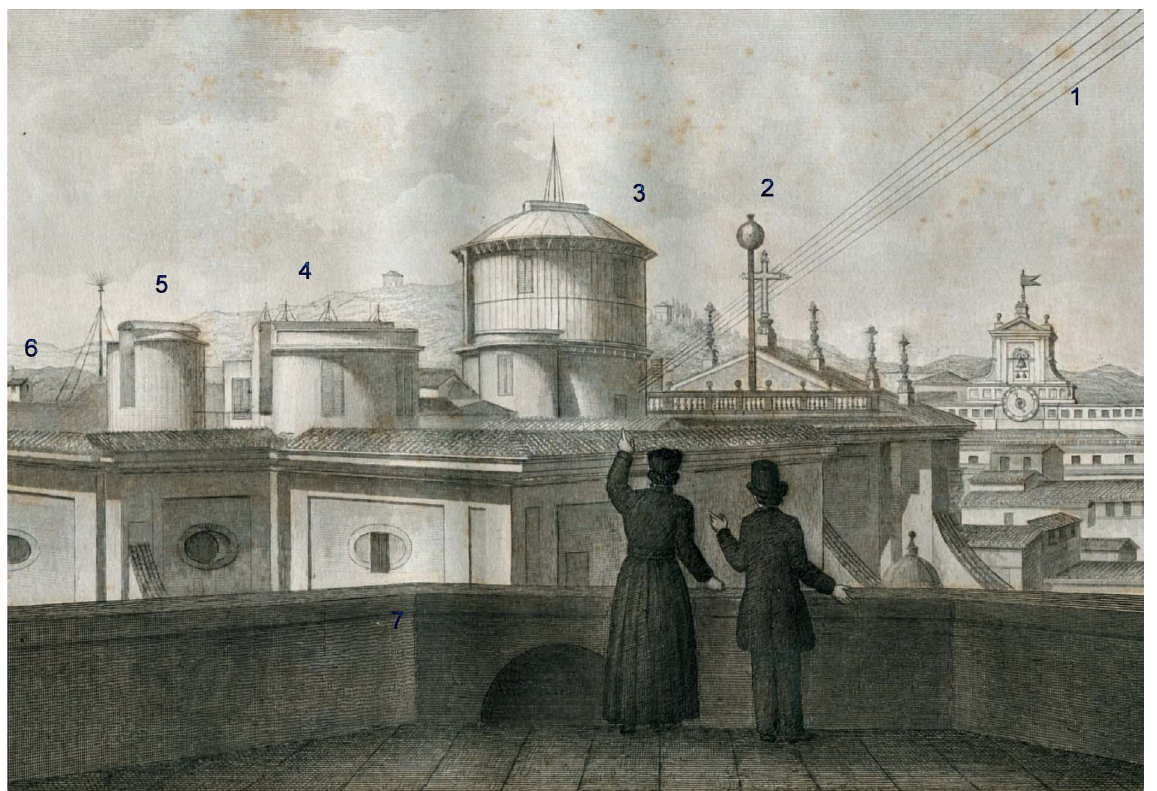
Fig. 1. Observatory of the Roman College seen from the Calandrelli Tower. The reproduction shows in order: 1) bundle of electric cables for the transmission of the signals of the meteorological sensors located on the Calandrelli Tower to the Secchi ’ s automatic Meteorograph; 2) pole with wicker ball, used, starting from 1847, to signal midday to the artillerymen of Castel S. Angelo; 3) dome with the Merz telescope; 4) elliptical observatory for the meridian circle of Ertel; 5) dome with the Cauchoix telescope; 6) electric turret observatory with the small ball conductor; 7) Median Terrace of the Calandrelli Tower. From Secchi ’ s communication L ’ astronomia in Roma nel ponti fi cato di Pio IX (Secchi,